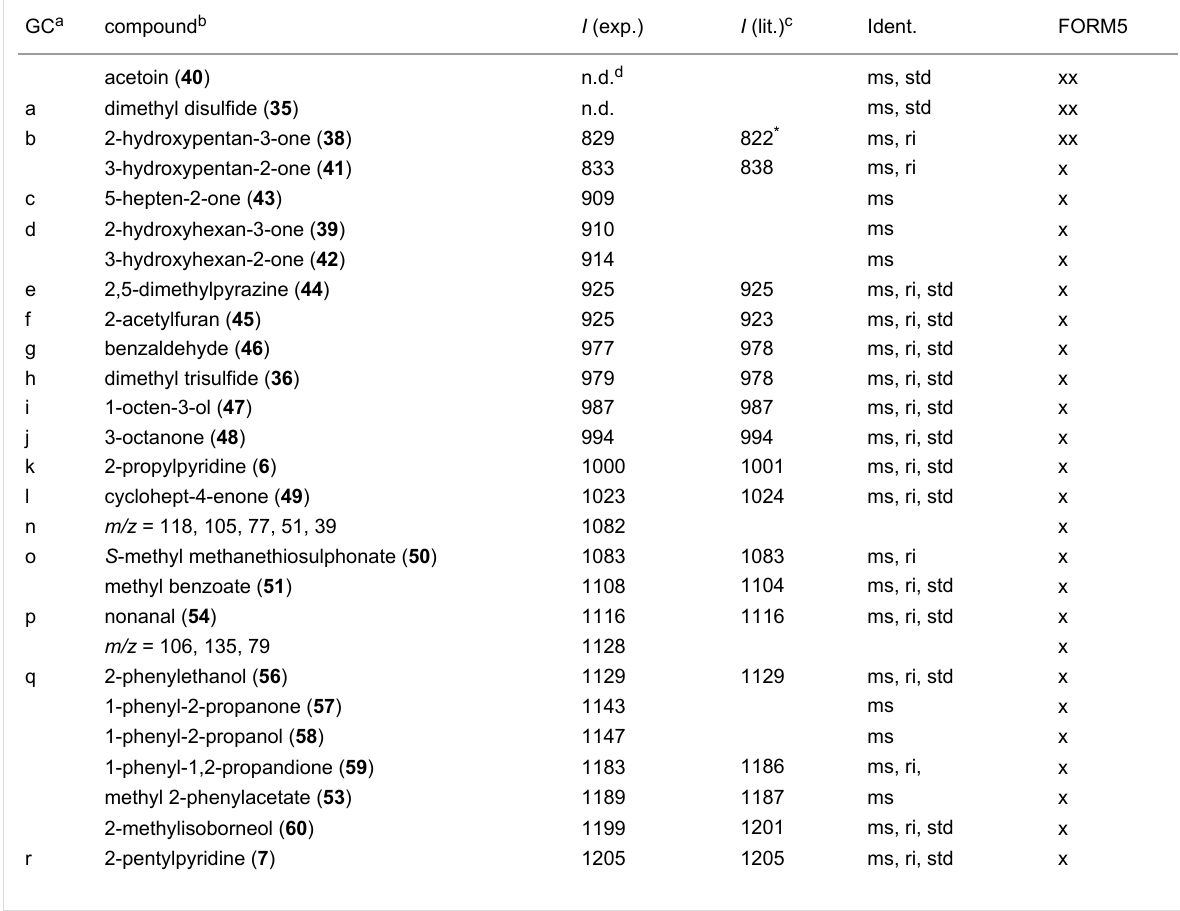
Table 1: Volatile compounds identified in the headspace extract of Streptomyces strain FORM5. The amounts of the compounds are given as 0–2% (x), 2–8% (xx), >8% (xxx) relative to the largest peak area in the total ion chromatogram. The identification of the compound based on comparison of mass spectrum to a data base spectrum (ms), comparison of retention index to a published retention index on the same or similar GC fused silica capillary column (ri), and/or based on comparison to a synthetic or commercially available reference compound (std). GC